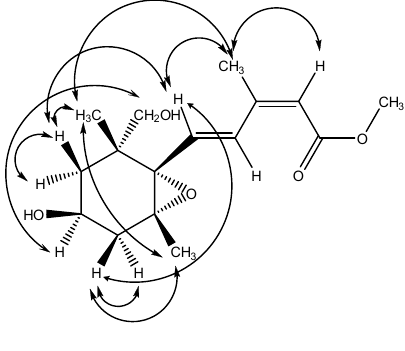
Figure 3. NOESY Correlations of 1 .